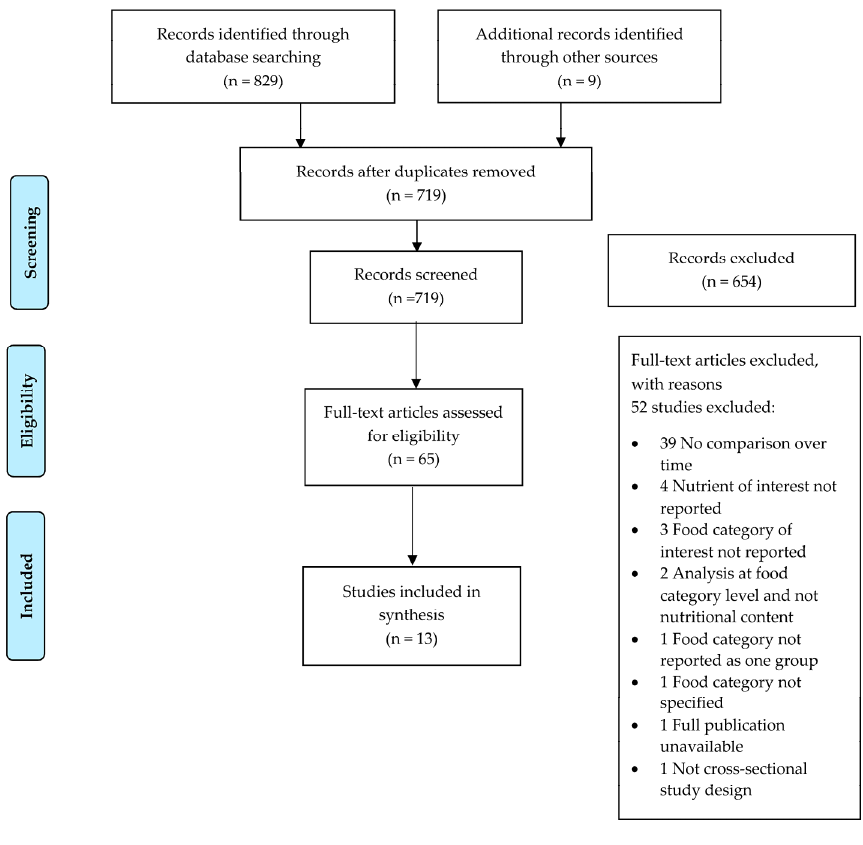
Figure 1. PRISMA Flow Diagram of Literature Review.